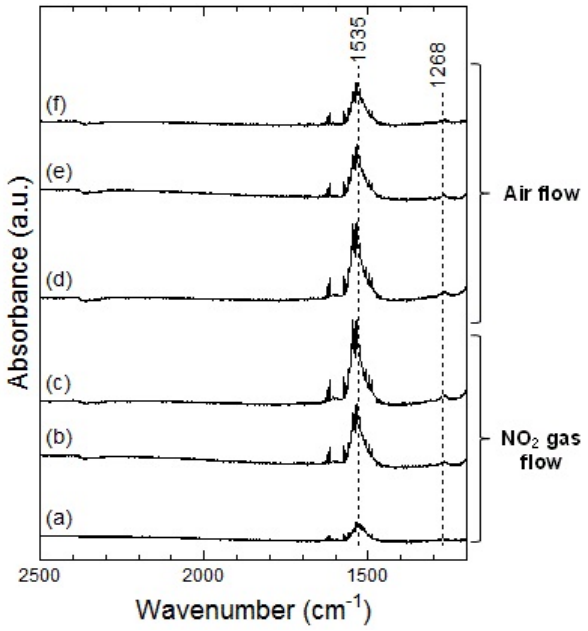
Figure 12. DRIFT spectra of Co O powder at 200 °C. The powders were exposed to 3 4 1 ppm of NO in air for ( a ) 2 min, ( b ) 20 min, and ( c ) 50 min. After NO 2 powders were purged by air for ( d ) 1 min, ( e ) 30 min, and ( f ) 60